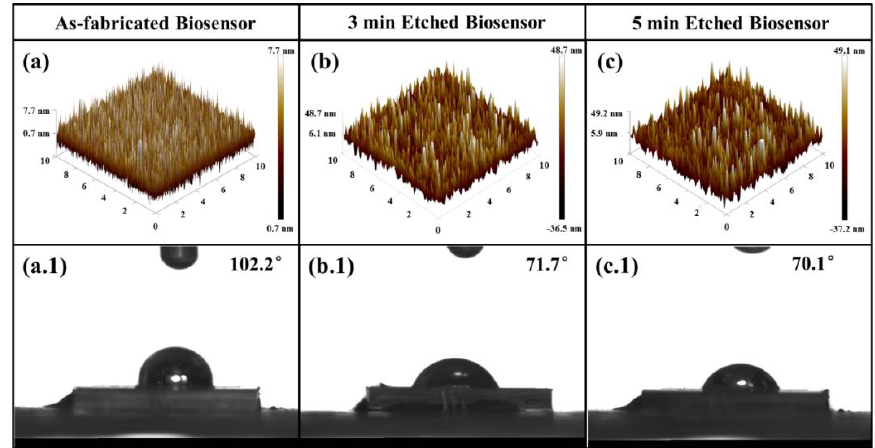
Figure 4. The AFM 3-D view of surface morphologies of top Au layers with ( a ) as-fabricated, ( b ) 3 min etched, and ( c ) 5 min etched. The images of 150 mg/dL glucose droplet onto biosensor with ( a.1 ) as-fabricated, ( b.1 ) 3 min etched, and ( c.1 ) 5 min etched.